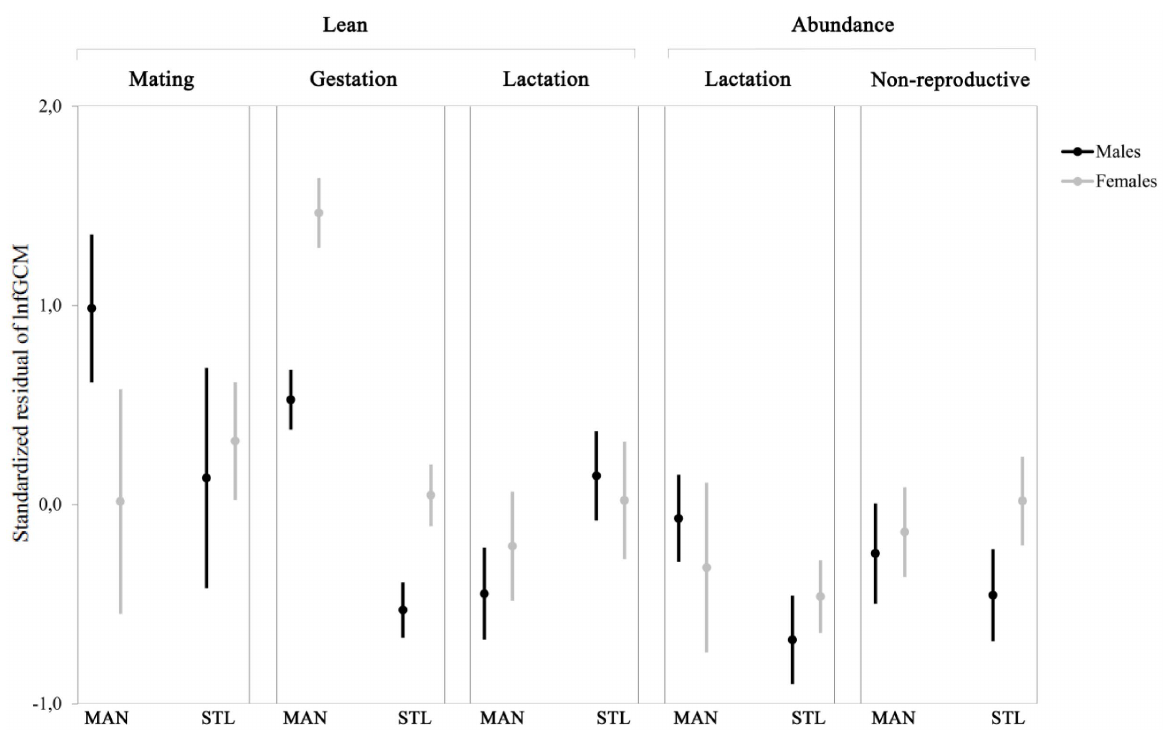
Figure 2. Fecal glucocorticoid metabolite levels of Eulemurcollaris over the study period. The figure shows standardized residuals of lnfGCM after controlling for the sample weight. MAN: Mandena, STL: Sainte Luce. Lean: May–October 2011, Abundance: February–April 2011 and November 2011–January 2012. Mating: 1 st May–15 th July, Gestation: 16 th July–30 th September, Lactation: 1 st October–31 st December, Non- reproductive: 1 st January–30 th April. Values are means and standard errors.